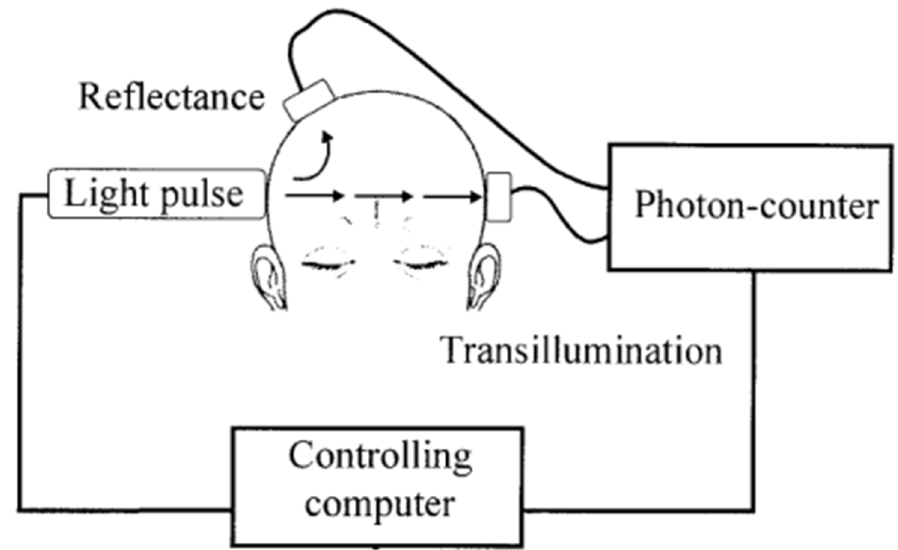
Figure 5. The basic structure of NIRS-based equipment for rSO 2 monitoring [81].